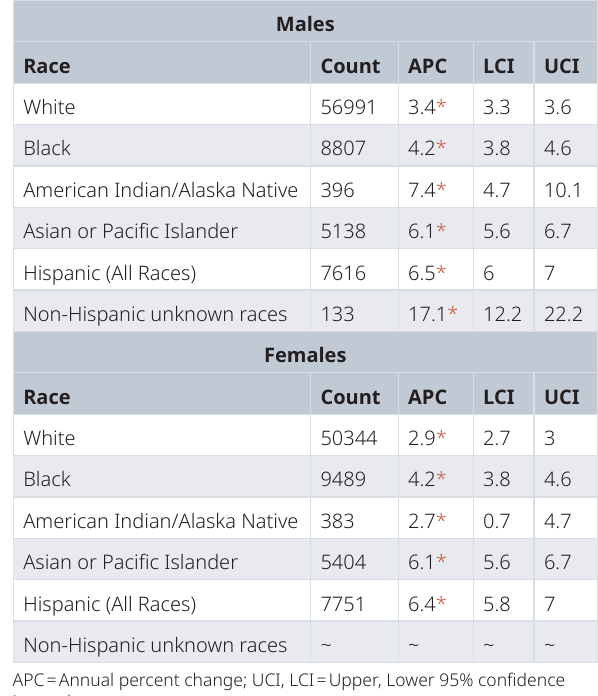
Table 1. Total cases and Annual Percentage Changes (APCs) of pancreatic cancer by race and gender